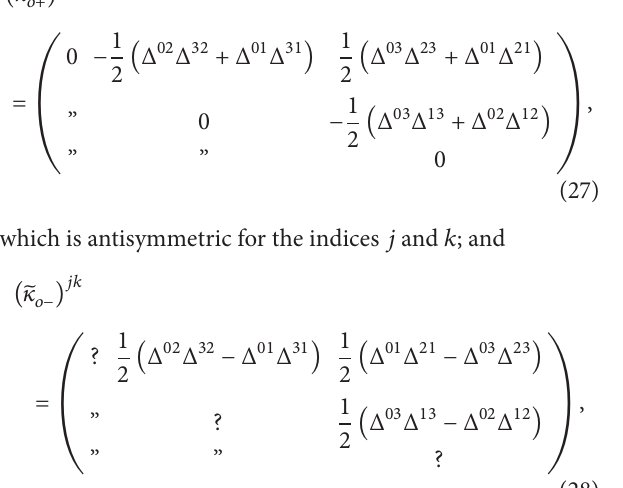
Table 3. There are 15 independent expressions in terms of Δ 𝛼𝛽 appearing in the four matrices (̃𝜅 𝑒+ )